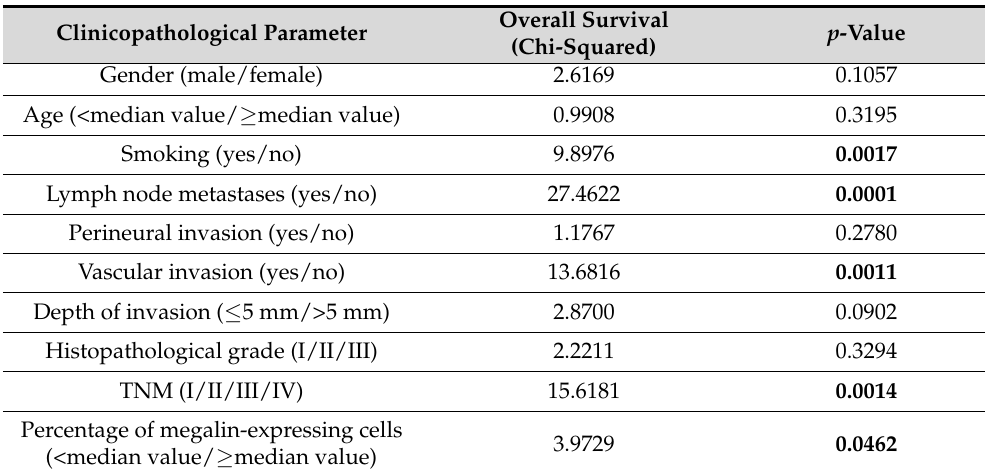
Table 2. Univariate Kaplan–Meier survival analysis with regard to clinicopathological parameters and percentage of megalin-expressing cells in primary OSCC tissue.